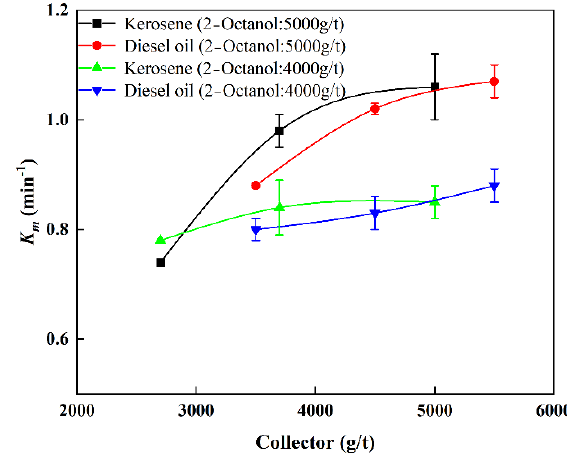
Figure 5. K m value under different dosage of collector.